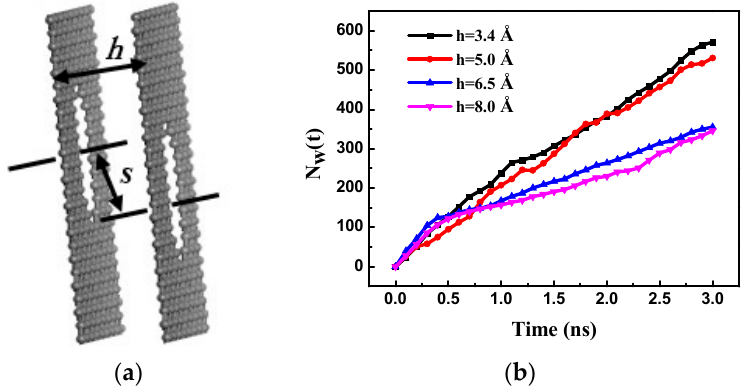
Figure 6. ( a ) Schematic diagram of the bilayer porous graphene membrane with a layer separation h and pore offset s ; ( b ) the number of water molecules passing through the bilayer porous graphene membranes over time for different layer separation distances.